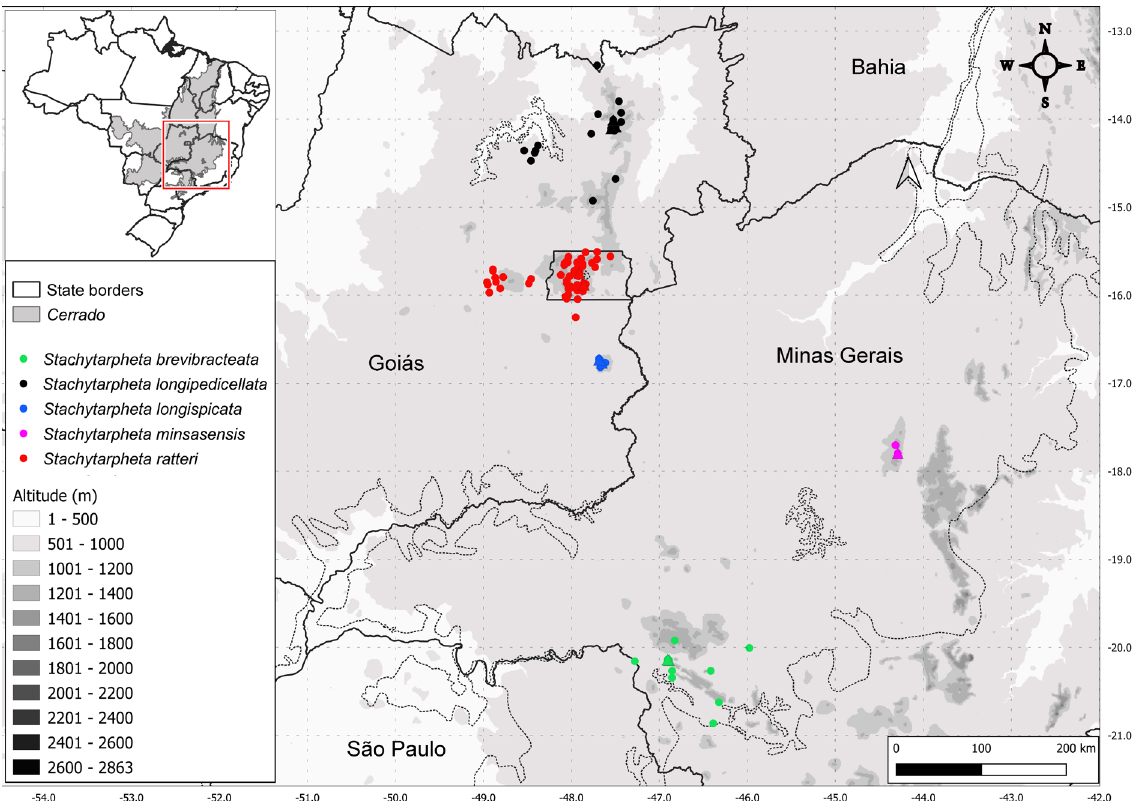
Fig. 5. Distribution map of the five species recognised in the Stachytarpheta longispicata complex in the present study. The triangles represent localities sampled during fieldwork for the morphometric